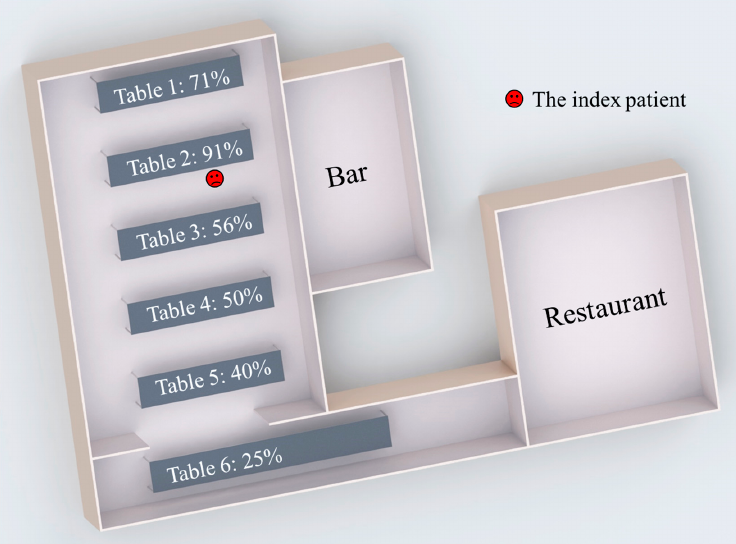
Figure 1. Floor plan of the site of the outbreak (restaurant) and the attack rates at different tables [21]. The location of the index patient is marked in